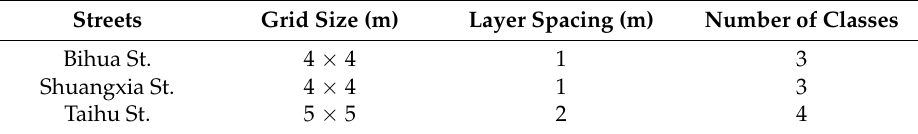
Table 4. Grid size, layer spacing, and the number of classes for coarse classification.